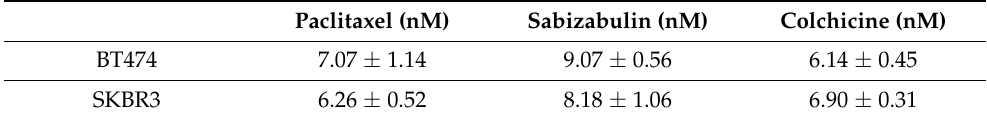
Table 1. Sabizabulin, paclitaxel, colchicine IC 50 values in HER2+ cells. IC 50 values ± SEM were determined as described in the Materials and Methods. Results from three independent experiments were averaged to report the grand